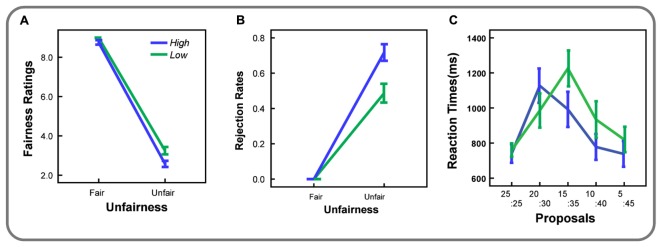
(A) Fairness ratings, (B) Rejection rates, and (C) Reaction times were plotted as a function of unfairness level in both economic status conditions. Error bars indicate SEM.